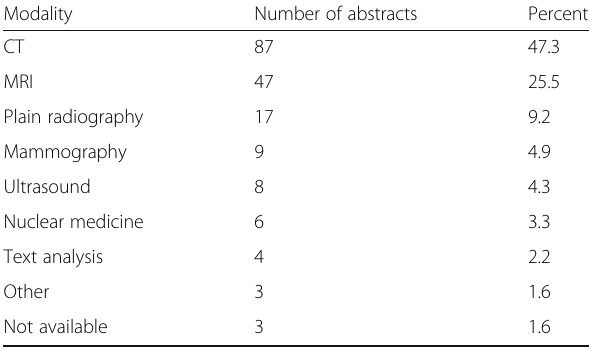
Table 3 Modalities featured in accepted abstracts